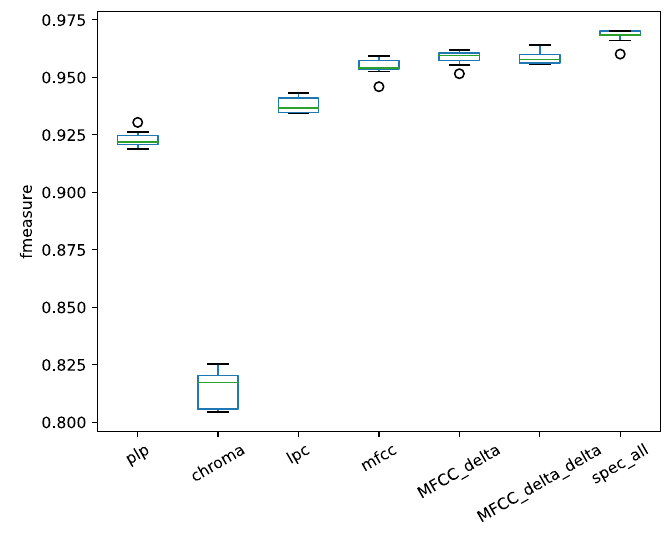
Figure 5. Performances of different features on the Jamendo dataset.